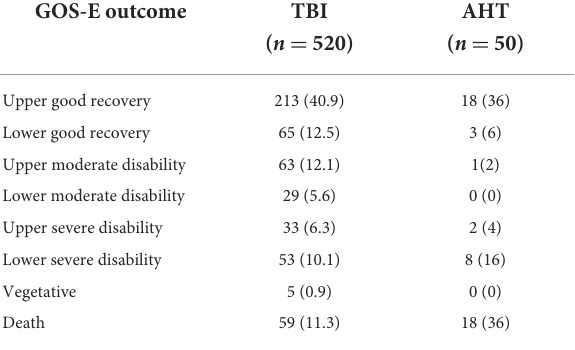
TABLE 5 Patient outcome by GOS-E in TBI (non-AHT) vs. AHT.